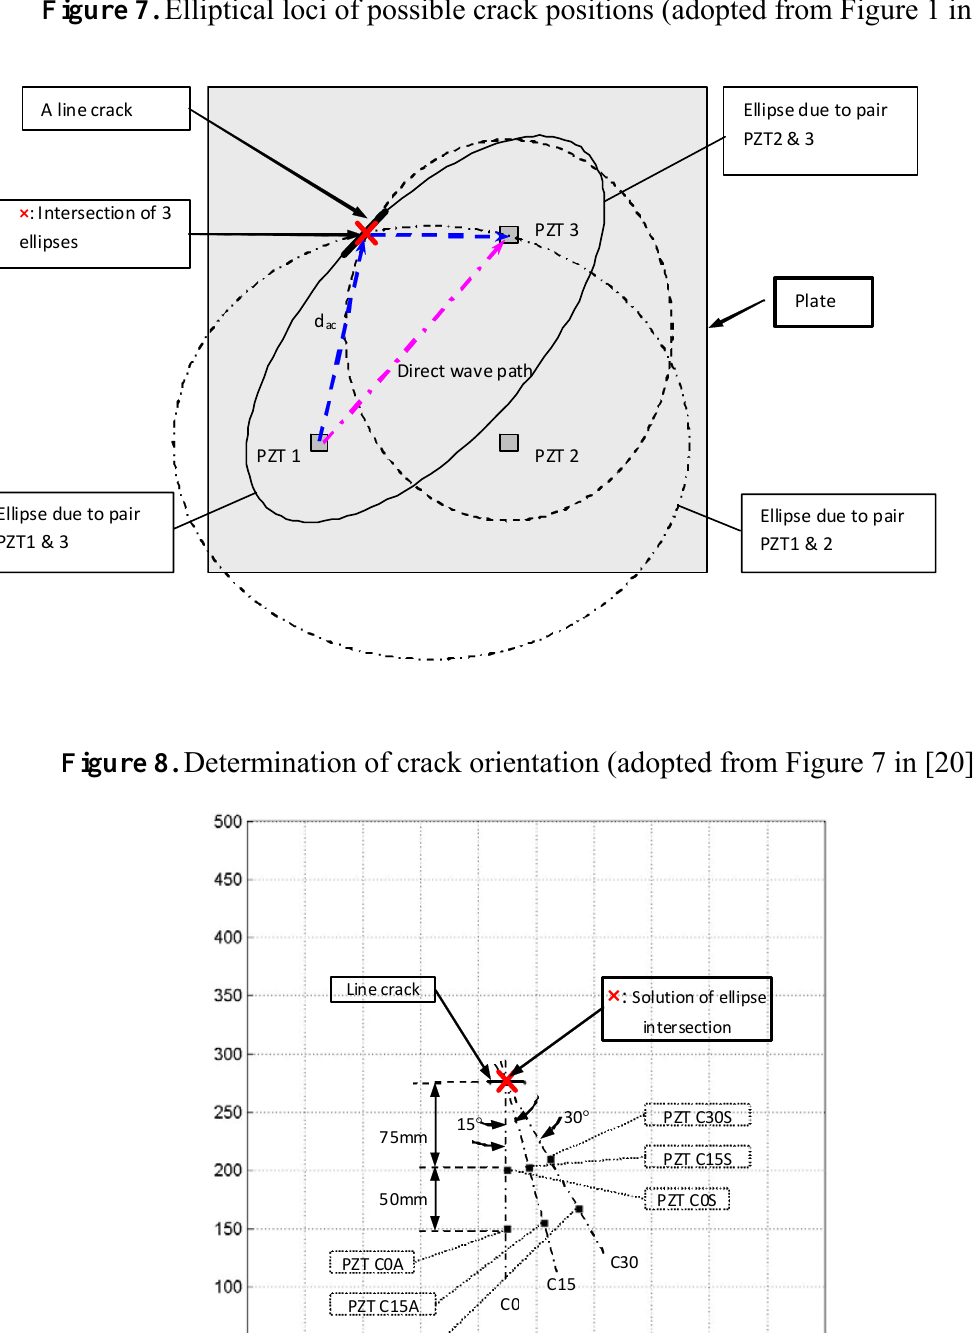
Figure 7. Elliptical loci of possible crack positions (adopted from Figure 1 in [20]).